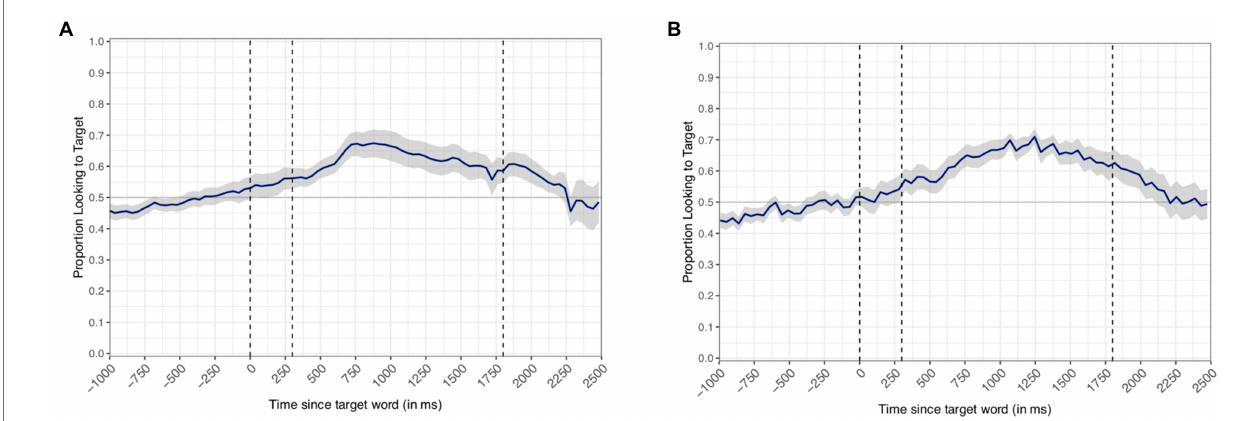
FIGURE 2 | Proportion of looks to a target image as a function of time. Dashed lines represent the onset of the target word (0 ms) and demarcate the primary window of interest from 300 to 1,800 ms. Graph (A) plots uncorrected time using the expected frame rate of 40 ms per frame (25 fps). Graph (B) plots time that has been corrected to reflect each individual infant’s mean-adjusted frame rate and normalized across participants to a frame rate of 43.84 ms per frame. Confidence bands represent